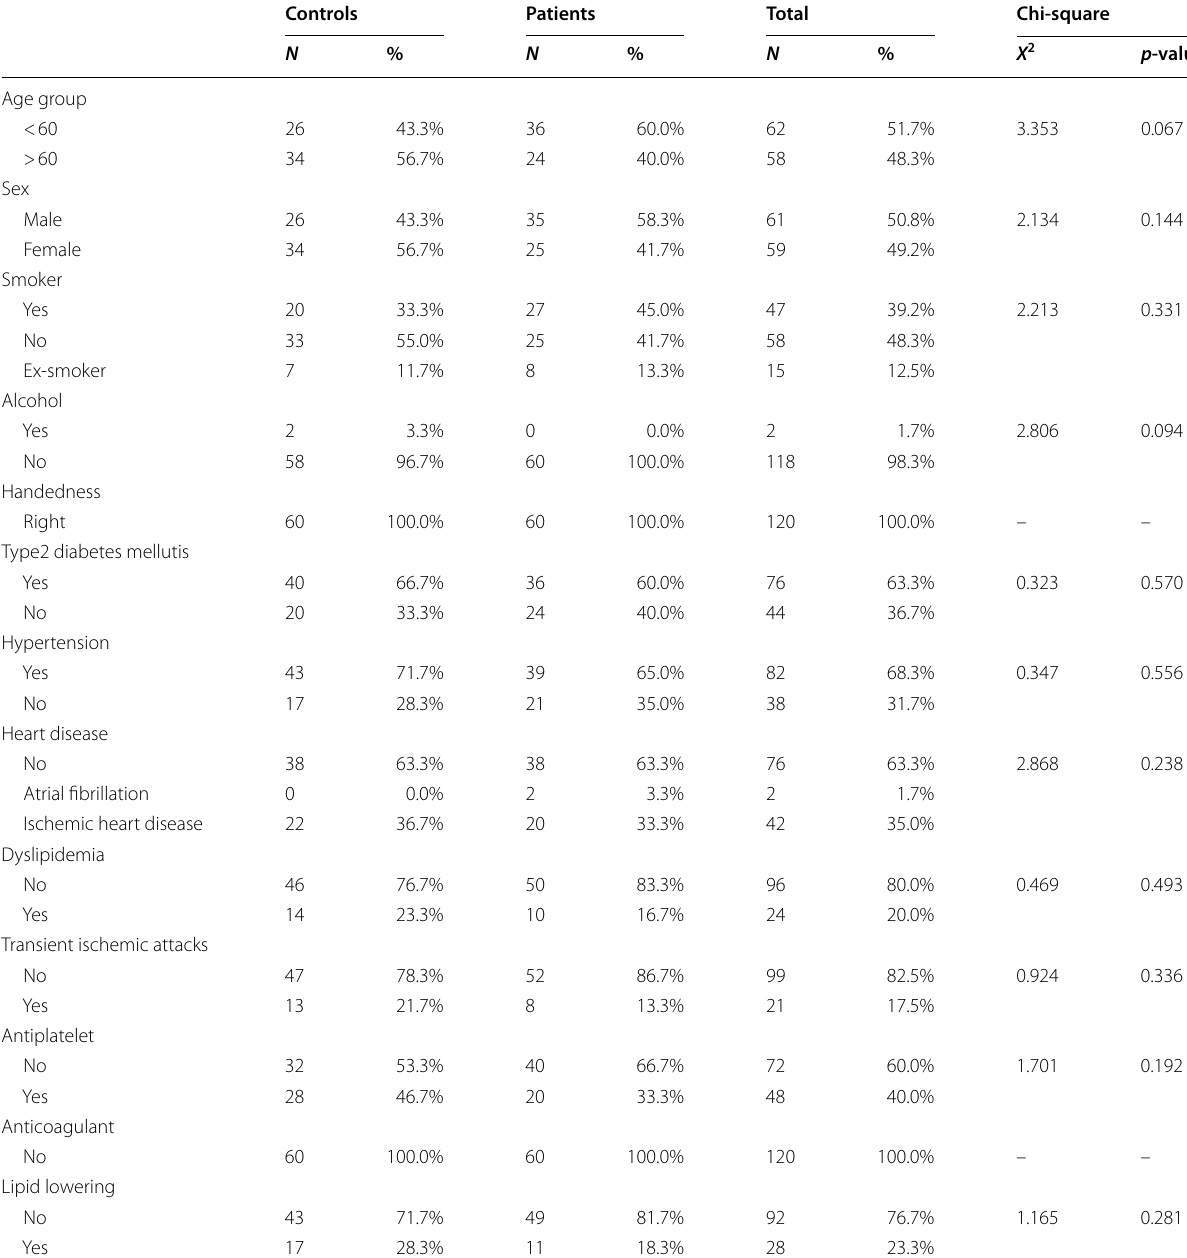
Table 1 Basic characteristics of patients in both groups: